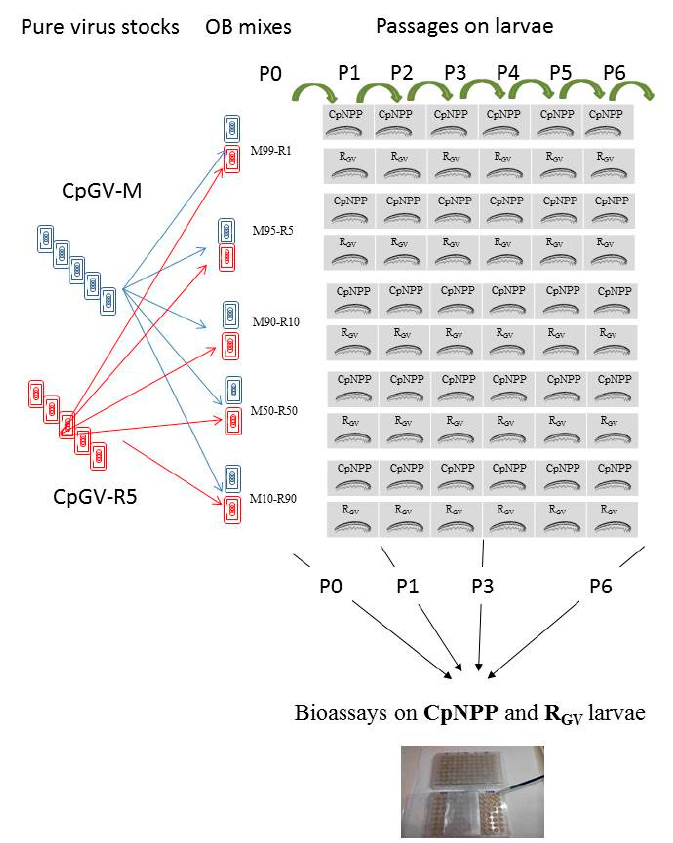
Figure 1. Schematic representation of the di ff erent mixed genotype lineages obtained by passaging mixed genotype virus populations on susceptible (CpNPP) and resistant (R GV ) insects. The bioassays on CpNPP and R GV neonate larvae were performed using Passage 1 (P1), P3, and P6 viruses. P0 (previously published) were used as a reference. OB, occlusion body.